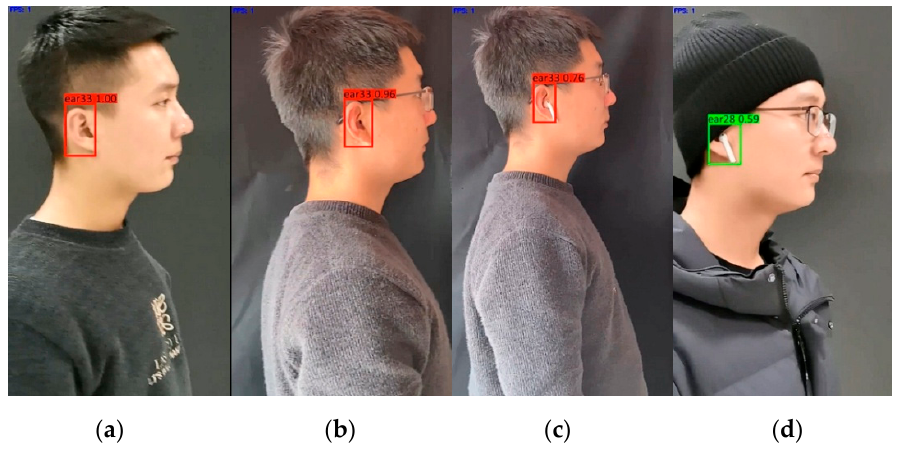
Figure 9. Experimental results of mAP with different occlusion: ( a ) unobstructed; ( b ) glasses; ( c ) glasses and earphones; ( d ) glasses, earphones and